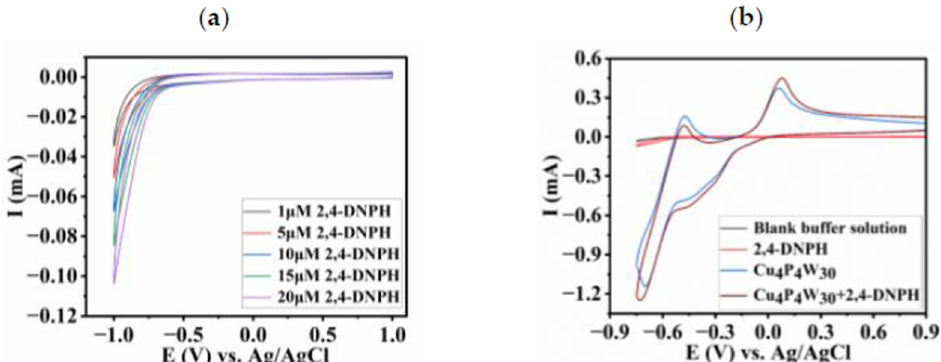
Figure 6. CVs of bare ITO in 2,4-DNPH at different concentrations (pH 7) with scan rate of 50 mV · s − 1 ( a ) and CVs of bare ITO in different solutions (pH 7) with scan rate of 50 mV · s − 1 ( b ).